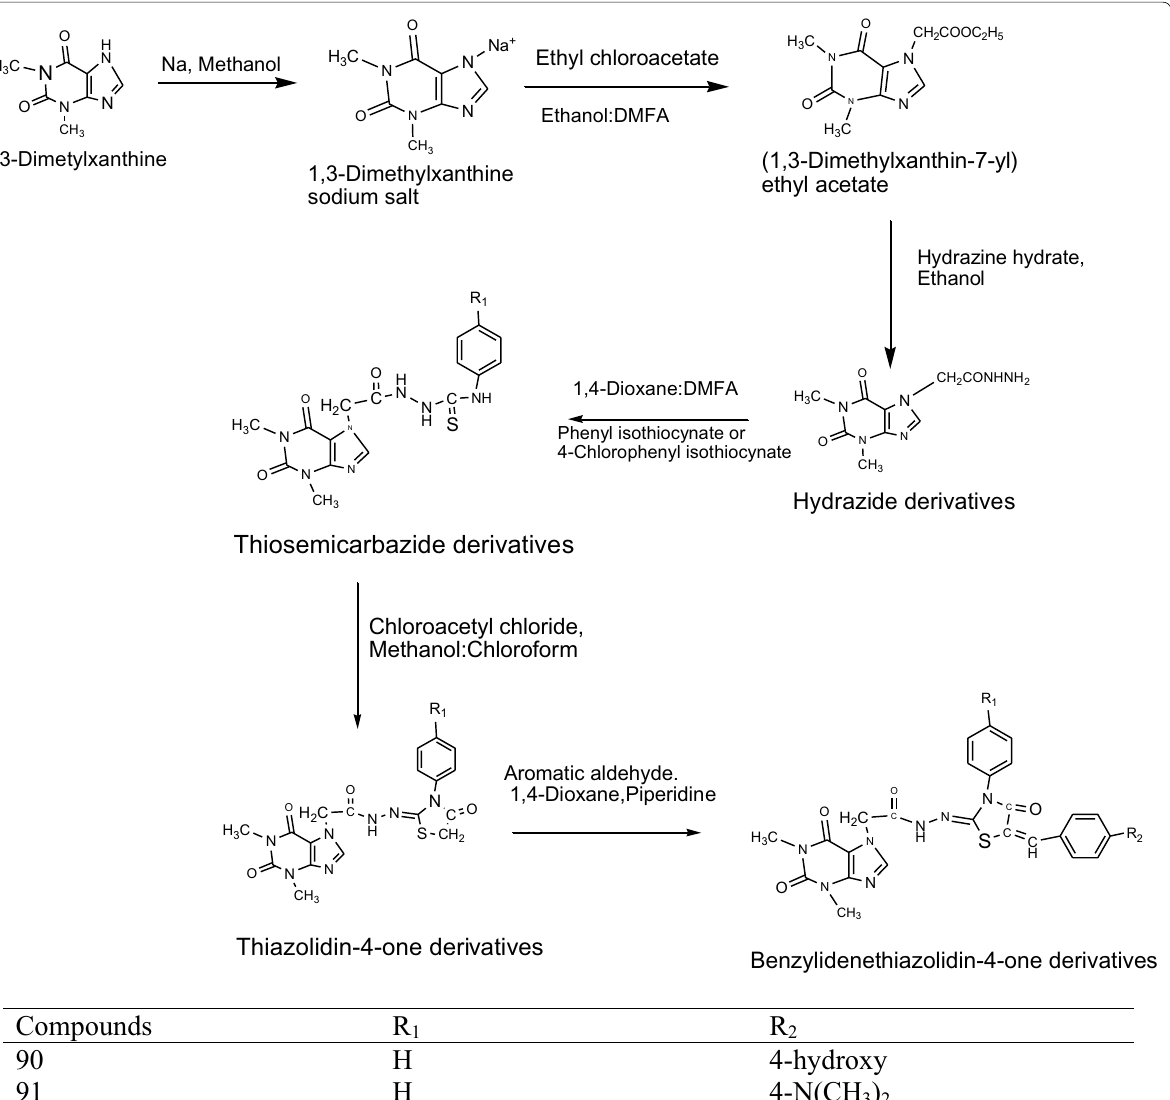
in Scheme 29 and appraised for anti-tubercular activi- ties with pyrazinamide and streptomycin as the stand- ard drug. Among all the synthesized derivatives,